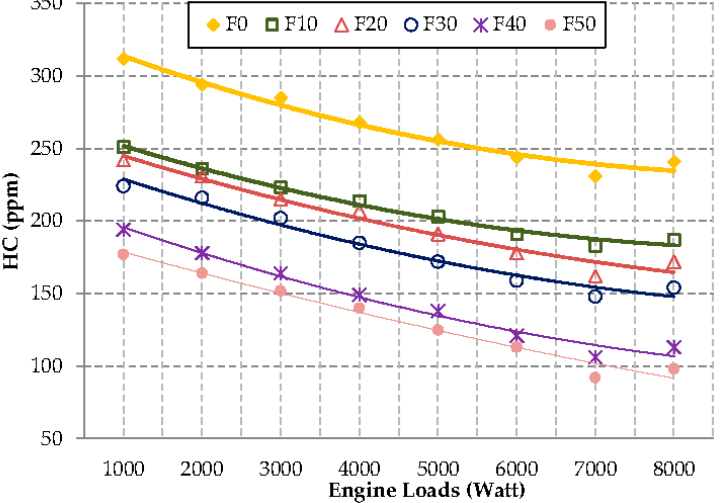
Figure 8. Hydrocarbon (HC) emission changes with engine loads.